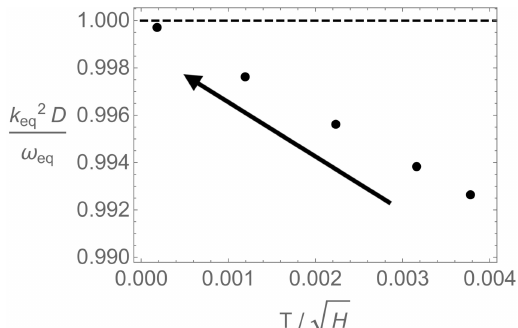
Figure 6 . The upper bound on the diffusion constant (2.12). The dashed line indicates the upper bound